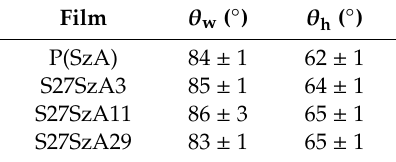
Table 3. Static contact angles of the block copolymer films with water ( θ w ) and n -hexadecane ( θ h ). Film